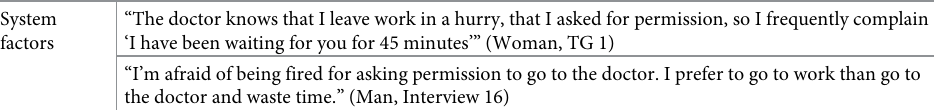
Table 8. Quotes related to system factors.